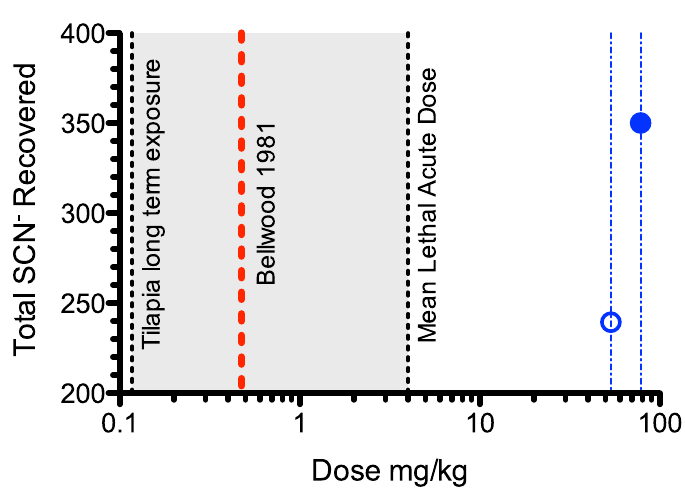
Fig 4. The minimum dose of cyanide required to achieve reported thiocyanate recovered over a 28 day depuration period reported by [13]. Blue circles are total thiocyanate (open circle is low dose and closed circle is high dose) reported and corresponding dose (blue dotted lines) reported by [13]. Red dotted line is the calculated dose from a radio labeled exposure study [20], see supplemental materials for calculations. Dashed lines are literature values depicting LC50 after 96 hour exposure for Tilapia [20] and mean lethal acute dose (4 mg/kg) an animal could receive and survive [15]. Gray shaded area indicates a plausible